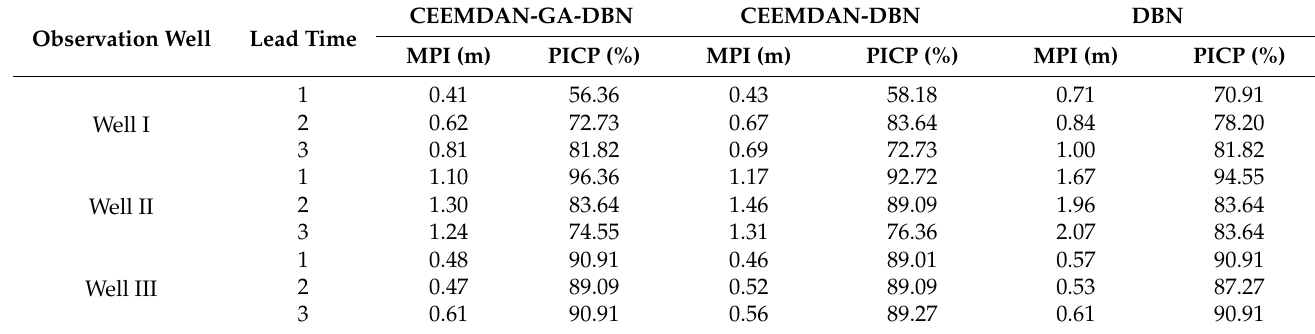
Table 8. Uncertainty analysis for the 1-, 2- and 3-month ahead GWL forecasts of the CEEMDAN-GA-DBN, CEEMDAN- DBN and DBN models at 95% confidence